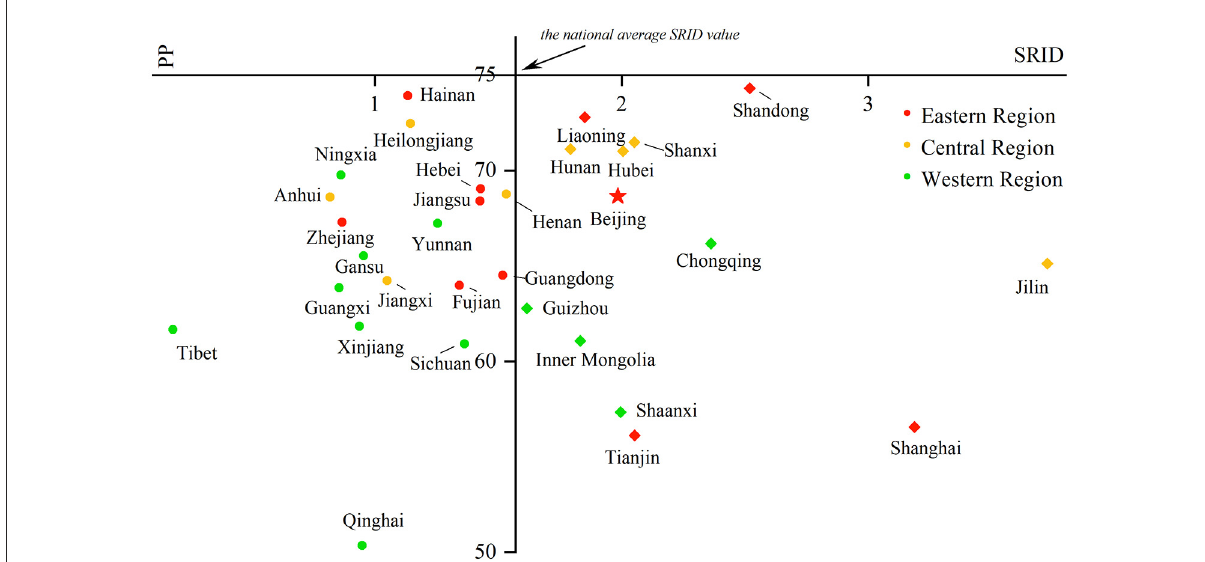
FIGURE5 Scatter plot with four quadrants for the proportion of professionals in 2016.